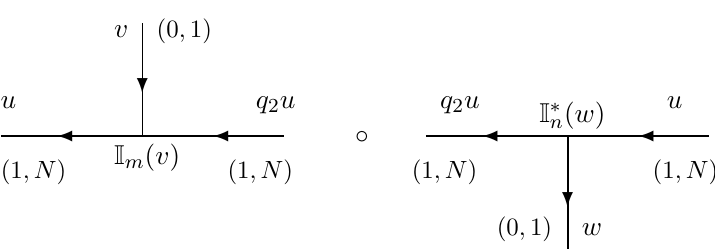
Figure 2 . Composition ◦ of the dual vector intertwiner and the vector intertwiner. Contrary to the Fock intertwiner, the level (1 , N ) of the horizontal Fock space is kept intact and the shift of the spectral parameter u is independent of the spectral parameters v, w of the vertical